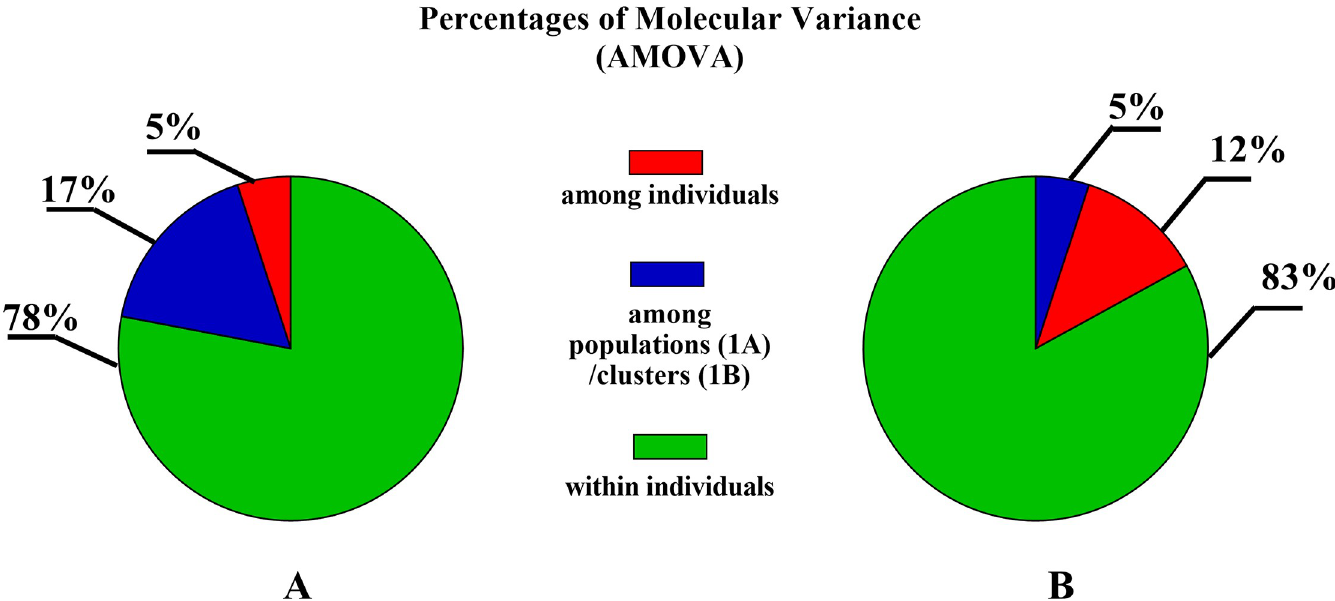
Fig 1. Genetic differentiation among populations (Pop1, Pop2, Pop3; Fig 1A) and clusters (C1, C2, C3, C4; Fig 1B) and among and within individuals calculated by AMOVA. Pop1, Polish draft horses; Pop2, semiferal Polish Konik horses; Pop3, Polish Konik horses, stabled group. Genetic clustering was based on the Bayesian method for K = 4.